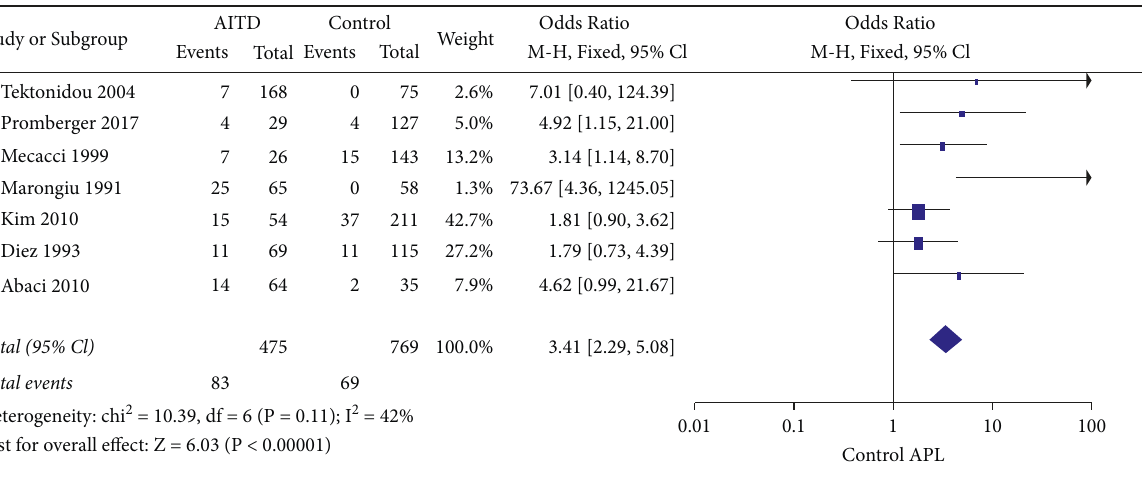
Figure 2: Forest plots for the prevalence of positive aPL in AITD patients compared with healthy controls. AITD: autoimmune thyroid diseases; APL: antiphospholipid antibodies; CI: confidence